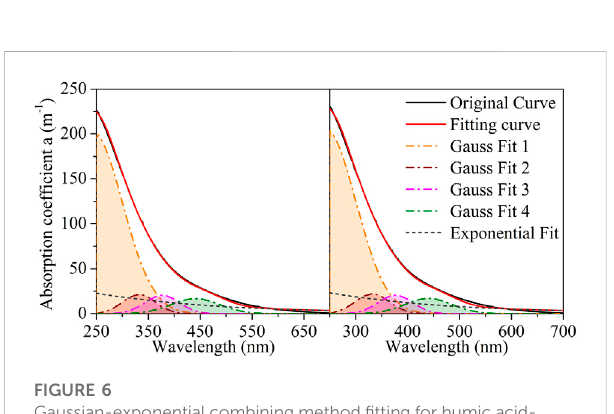
FIGURE 6 Gaussian-exponential combining method fi tting for humic acid- dissolved solution (HADS1 and HAD2 denote to the duplicated samples, HADS1 on the left and HADS2 on the